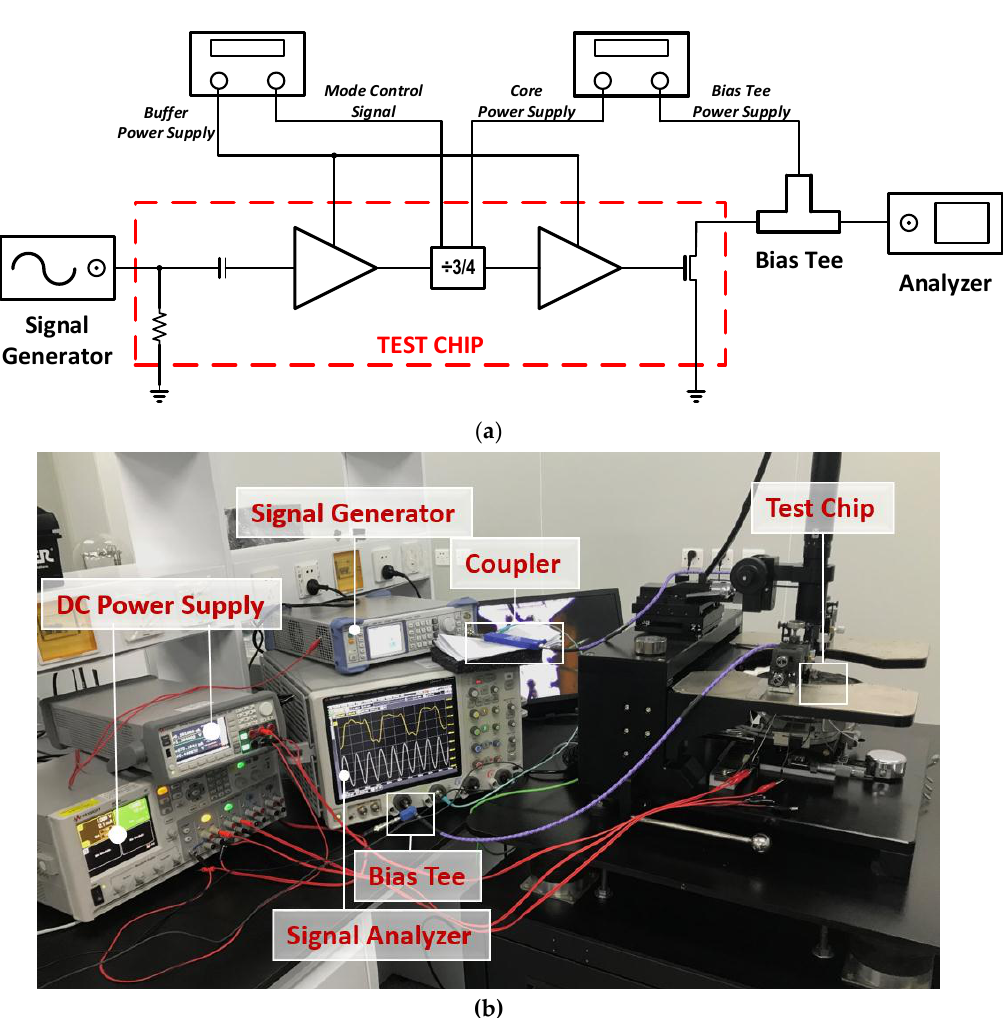
Figure 7. The test setup. ( a ) The block diagram of the test setup; ( b ) photo of the test